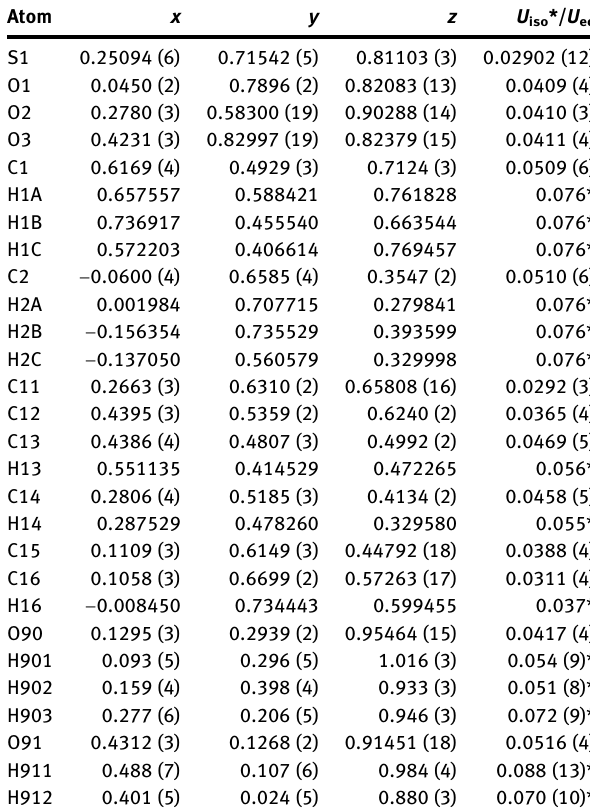
Table  : Fractional atomic coordinates and isotropic or equivalent isotropic displacement parameters (Å 